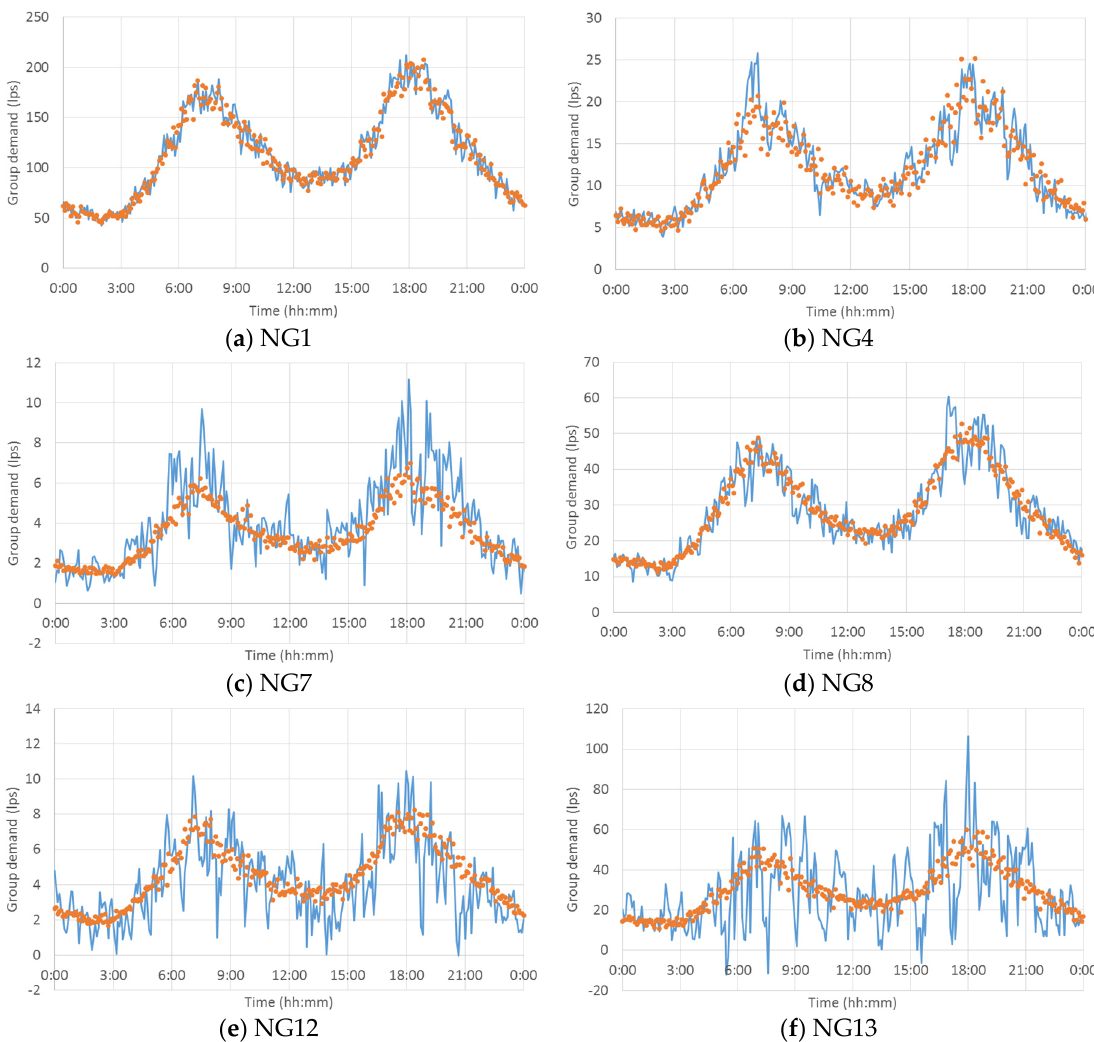
Figure 10. Actual (circle) and estimated (line) group demands at 5-min time steps for the first 24 h: ( a ) NG1; ( b ) NG4; ( c ) NG7; ( d ) NG8; ( e ) NG12; and ( f ) NG13 (NG = node group).